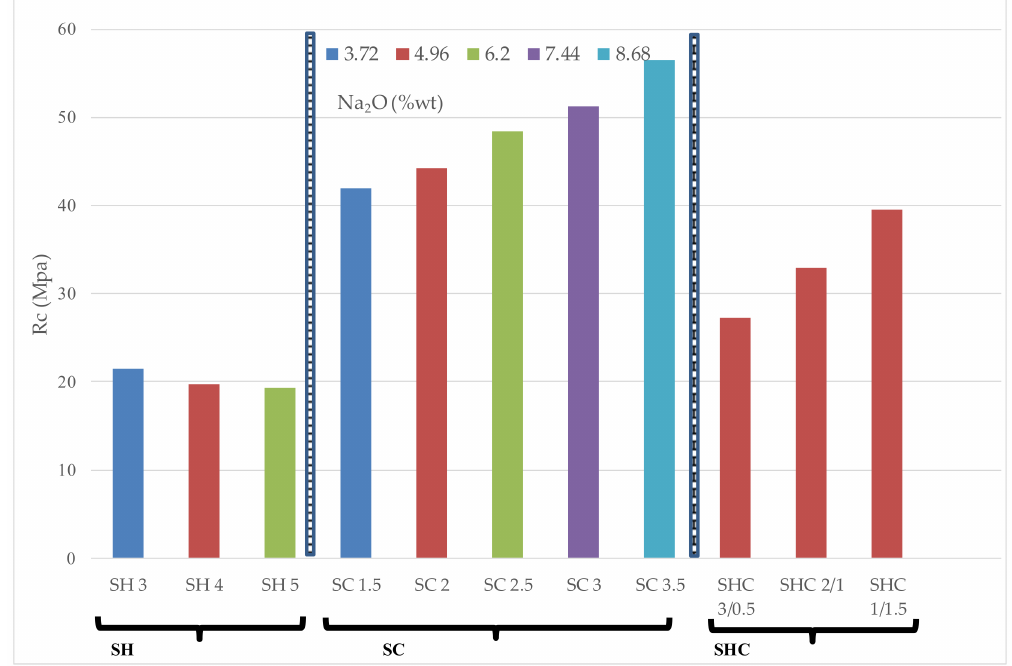
Figure 6. Compressive strength of mortars (cured for 28 days) according to Na 2 O percentage in relation to BFS